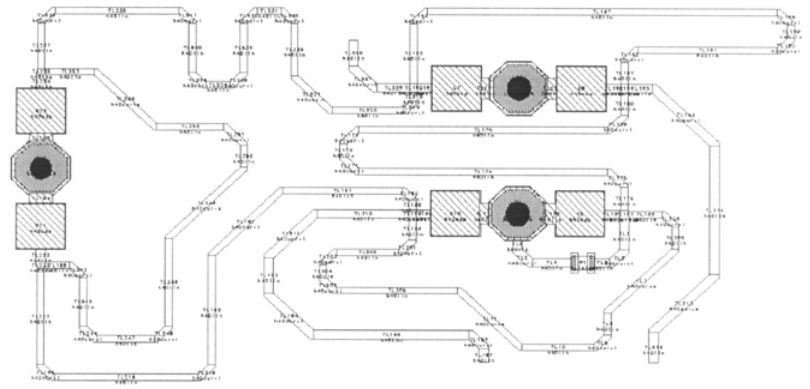
FIGURE 21 The 180-deg coupler’s final layout.